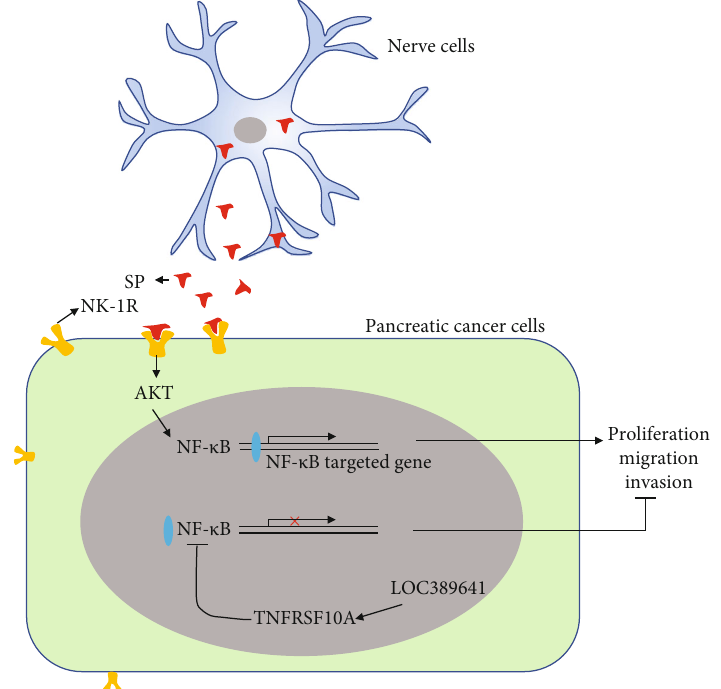
Figure 7: Diagram showing how the SP/NK-1R axis and lncRNA LOC389641 function in pancreatic